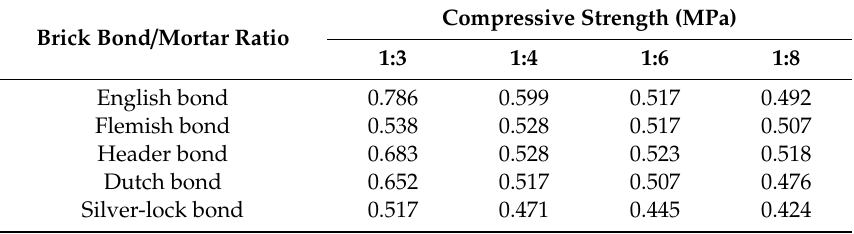
Table 6. Compression strength (MPa) of di ff erent brick masonry